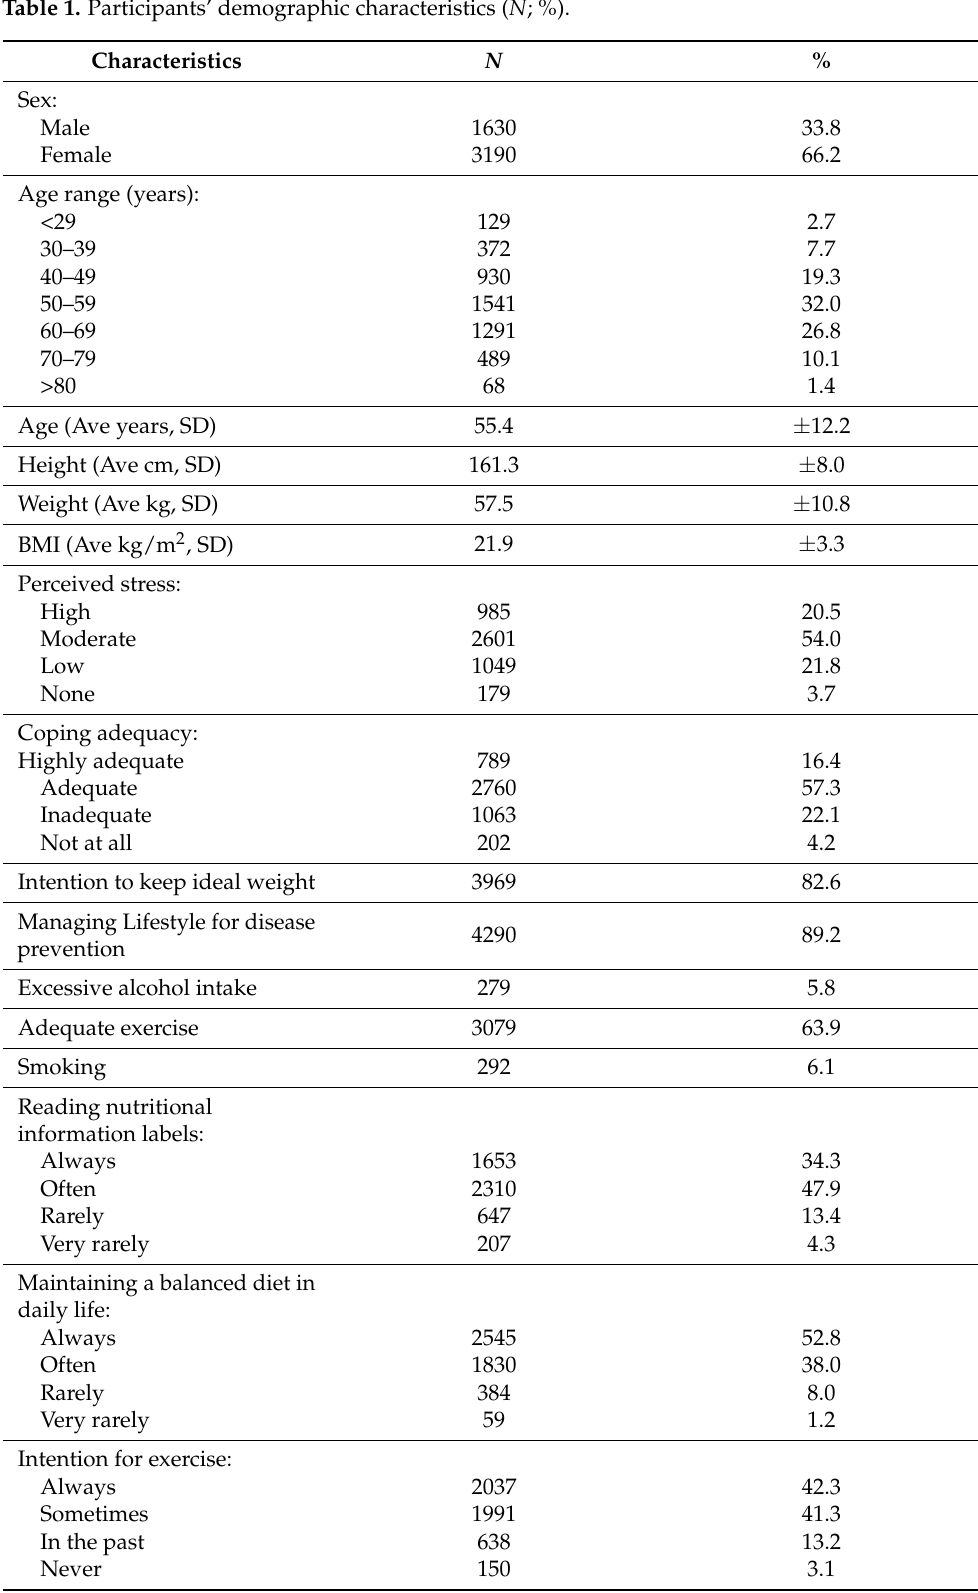
Table 1. Participants’ demographic characteristics ( N ;